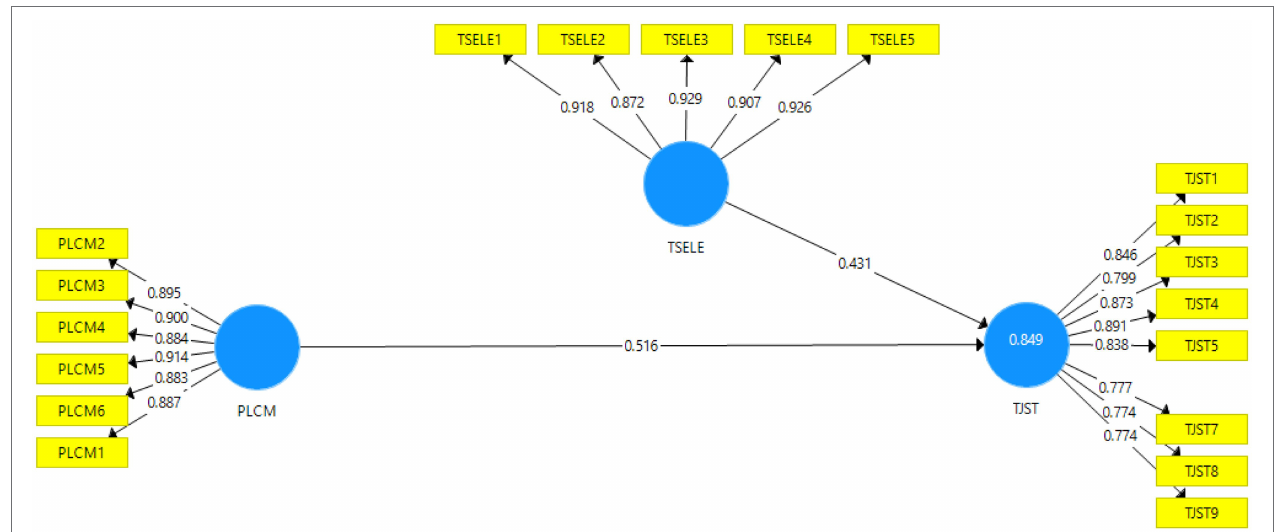
FIGURE 1 | Measurement model.